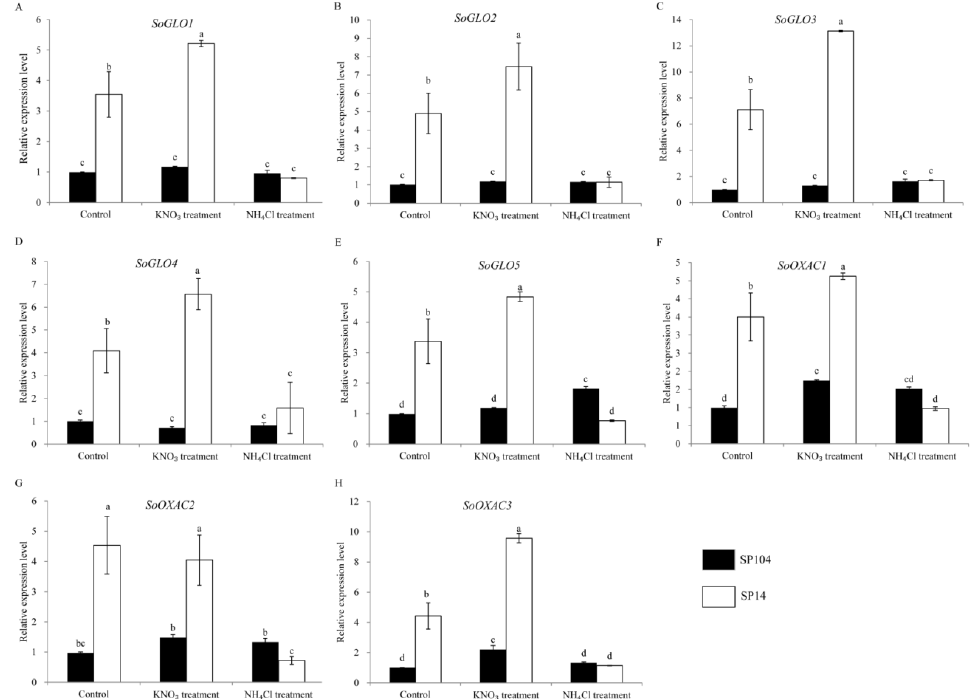
Figure 6. Expression profiles of putative genes involved in the oxalate biosynthesis pathways response to NH 4 + and NO 3 − treatments in the leaf laminas of spinach. Error bars represent standard deviation among three real-time quantitative PCR reaction replicates. Data are means of three replicates ± SD. Different lowercase letters indicate significant differences at P < 0.05.